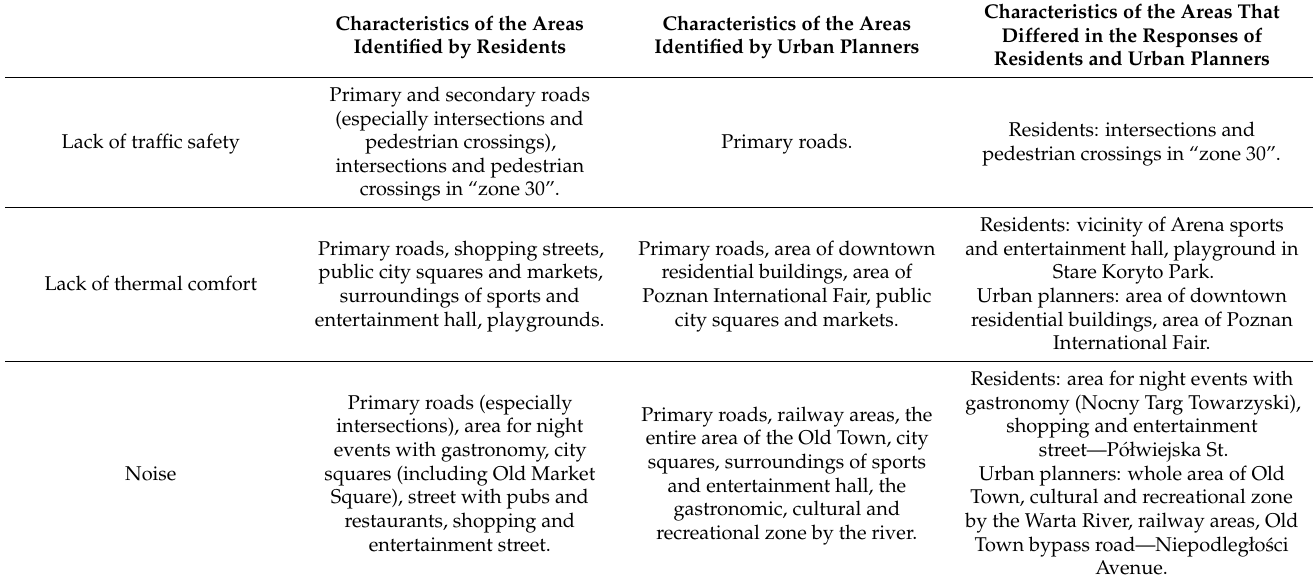
Table 4. Comparison of the assessment of selected features of space among two groups of respondents—residents and urban